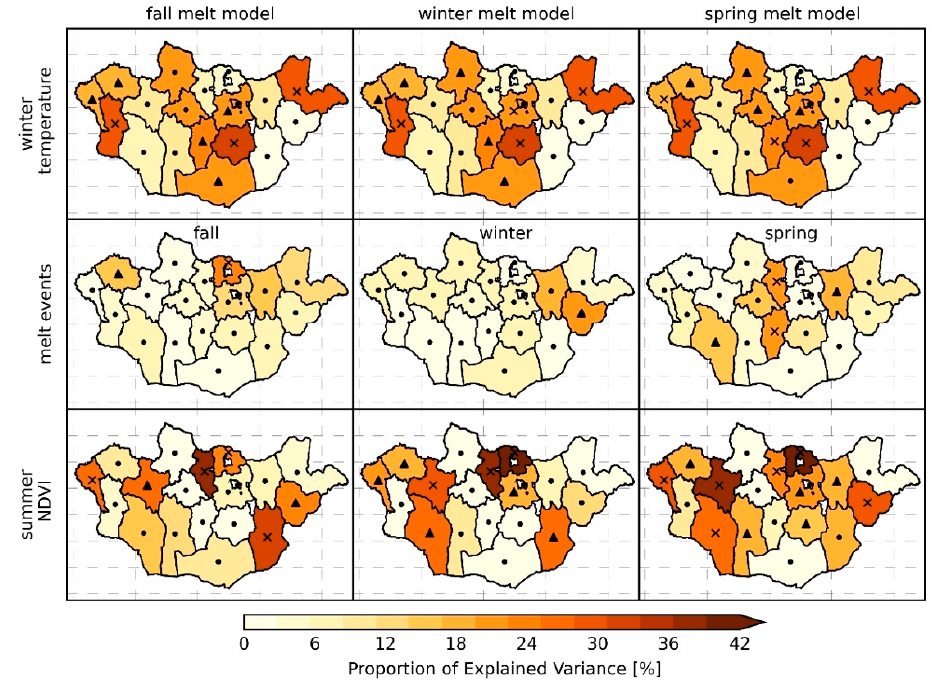
Figure 10. GLM results for the fall, winter, and spring. For each model, the proportion of total variance in annual MI explained by each environmental factor is represented. Black dots indicate weak correlations ( p > 0.1), black triangles indicate moderate correlations (0.05 ≤ p < 0.1) and the black ‘x’ symbols indicate strong correlations ( p < 0.05).